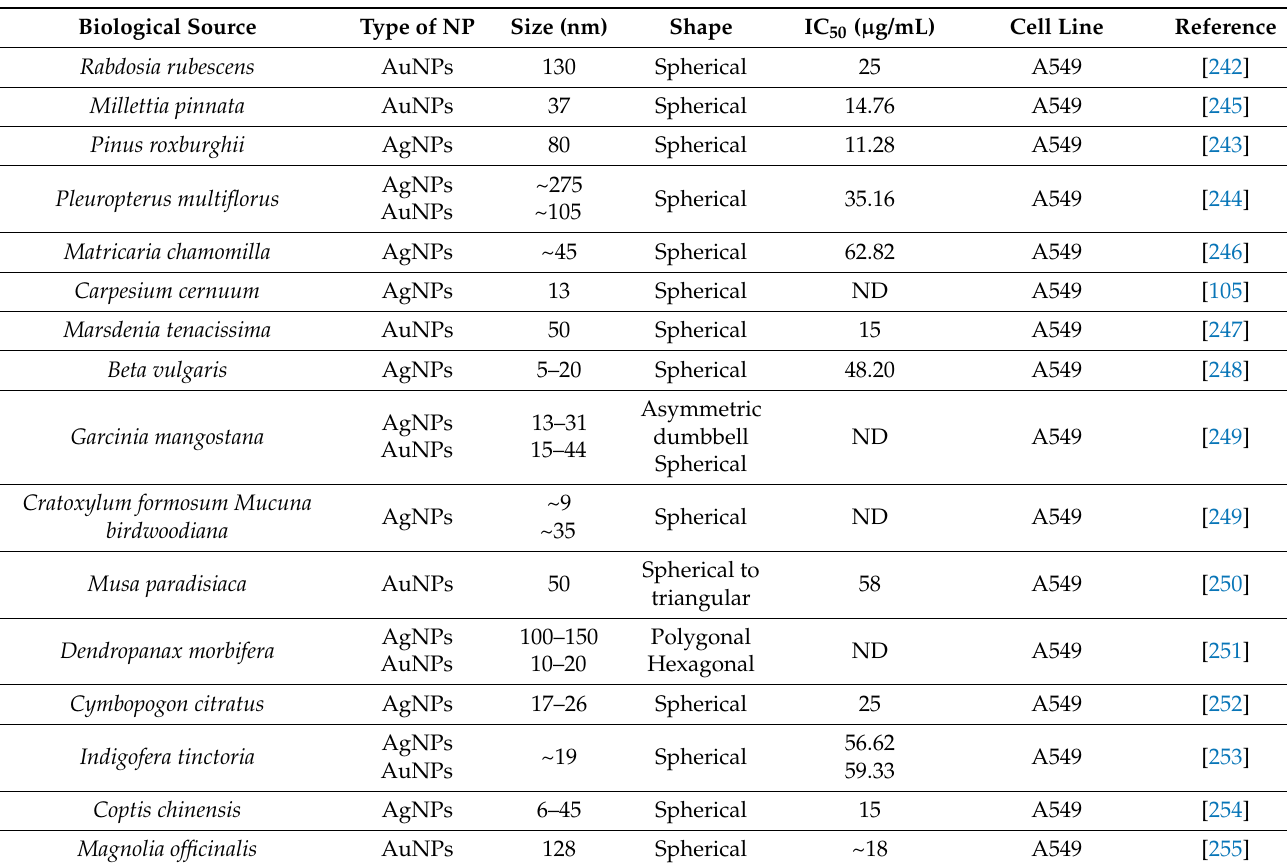
Table 7. Evaluation of green biogenic Au and AgNPs in lung cancer cells (A549 cell line); biological source, NPs characteris- tics, and IC 50